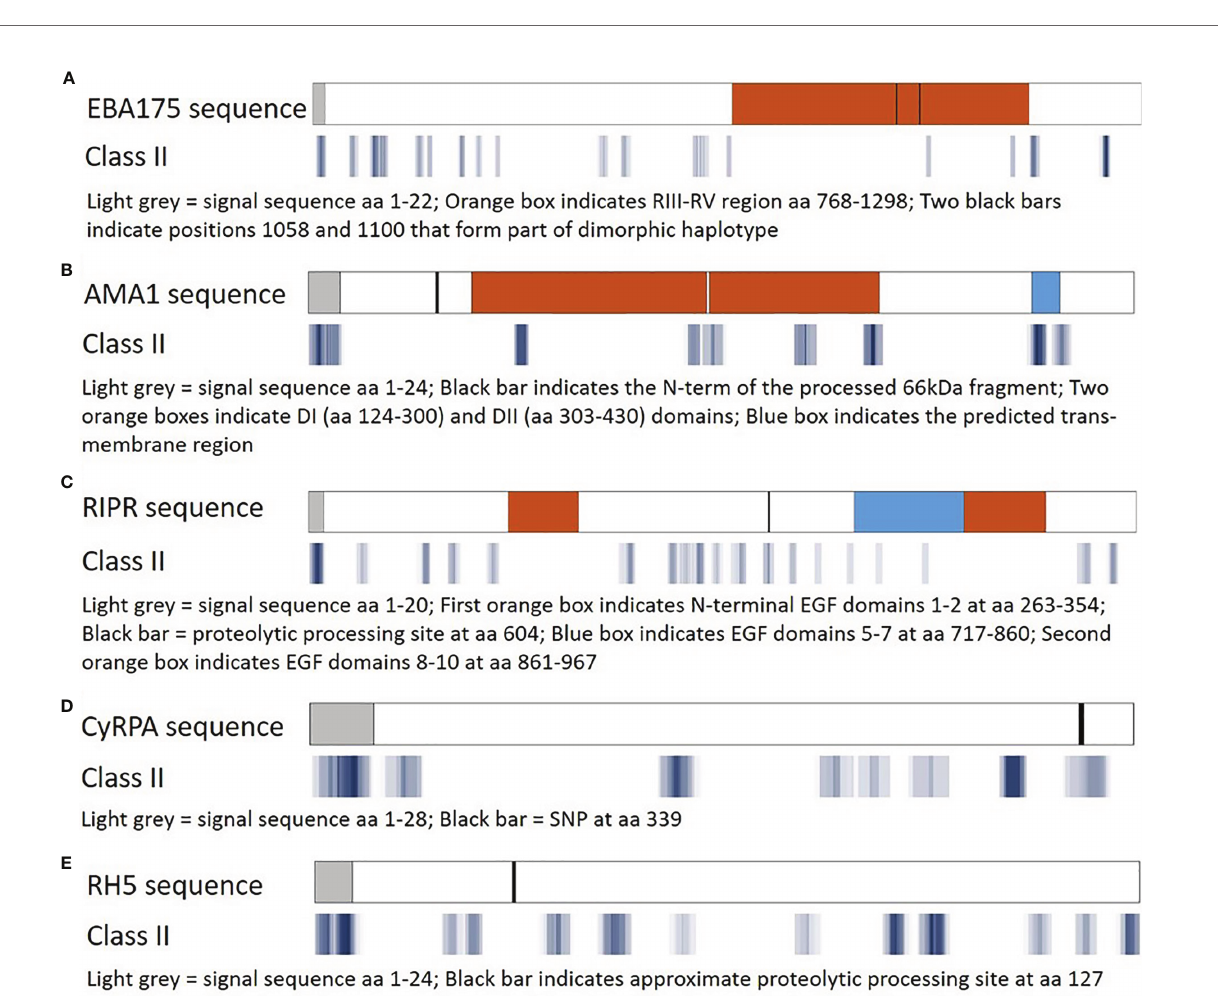
( Figure 3D ). In RH5, the C-terminal proteolytic fragment contains most of the predicted class II clusters ( Figure 3E ).